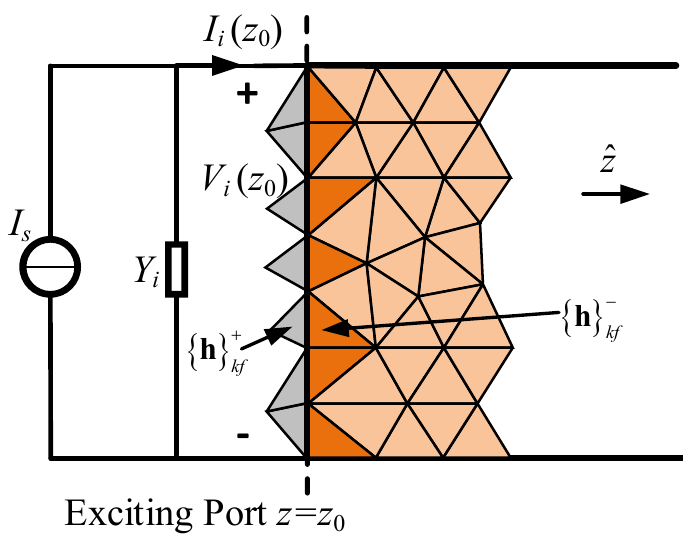
Figure 3. Equivalent modal excitation circuit for the WLTL.